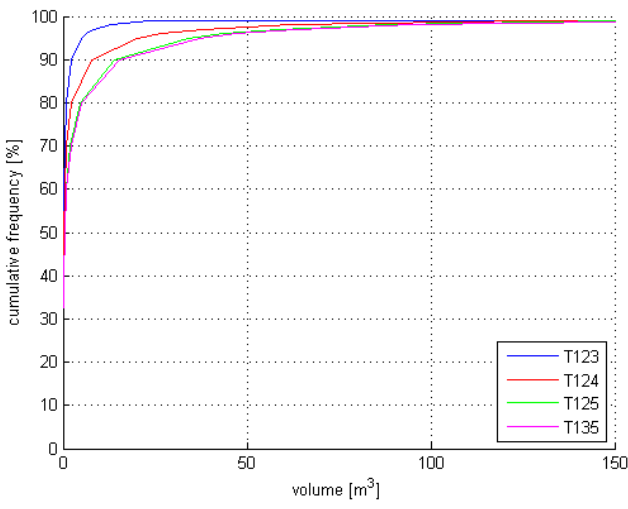
Geosciences 2020 , 10 , x FOR PEER REVIEW Figure 9. Sample CDF (SCDF) of the considered terns. Figure 9. Sample CDF (SCDF) of the considered terns.